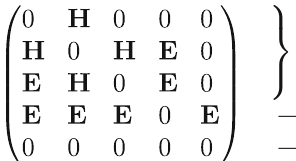
⎫ ⎬ Contributions are coupled: Every contribution receives all deformations ⎭ that occur within the group. → Deform with ellipsoids that itself contains. → No deformation needed